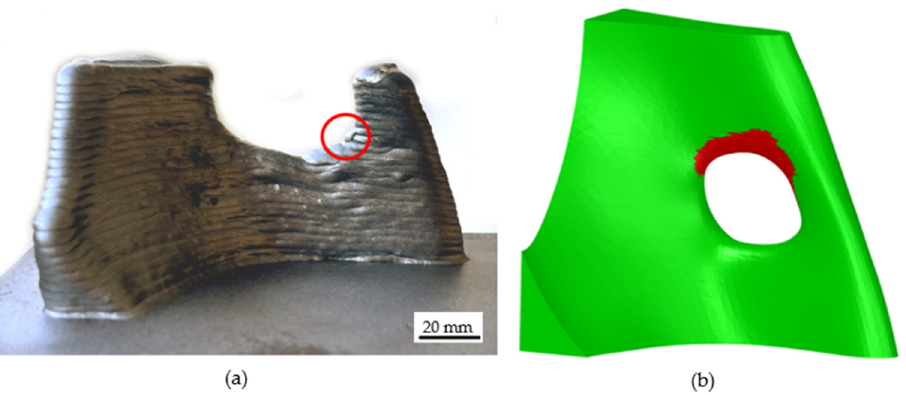
Figure 13. Criterion of overhang parallel to the welding direction: ( a ) result of a 3 axis manufacturing of the part with droplets forming at an overhang of 18 ◦ and ( b ) overhang analysis with a threshold of 18 ◦